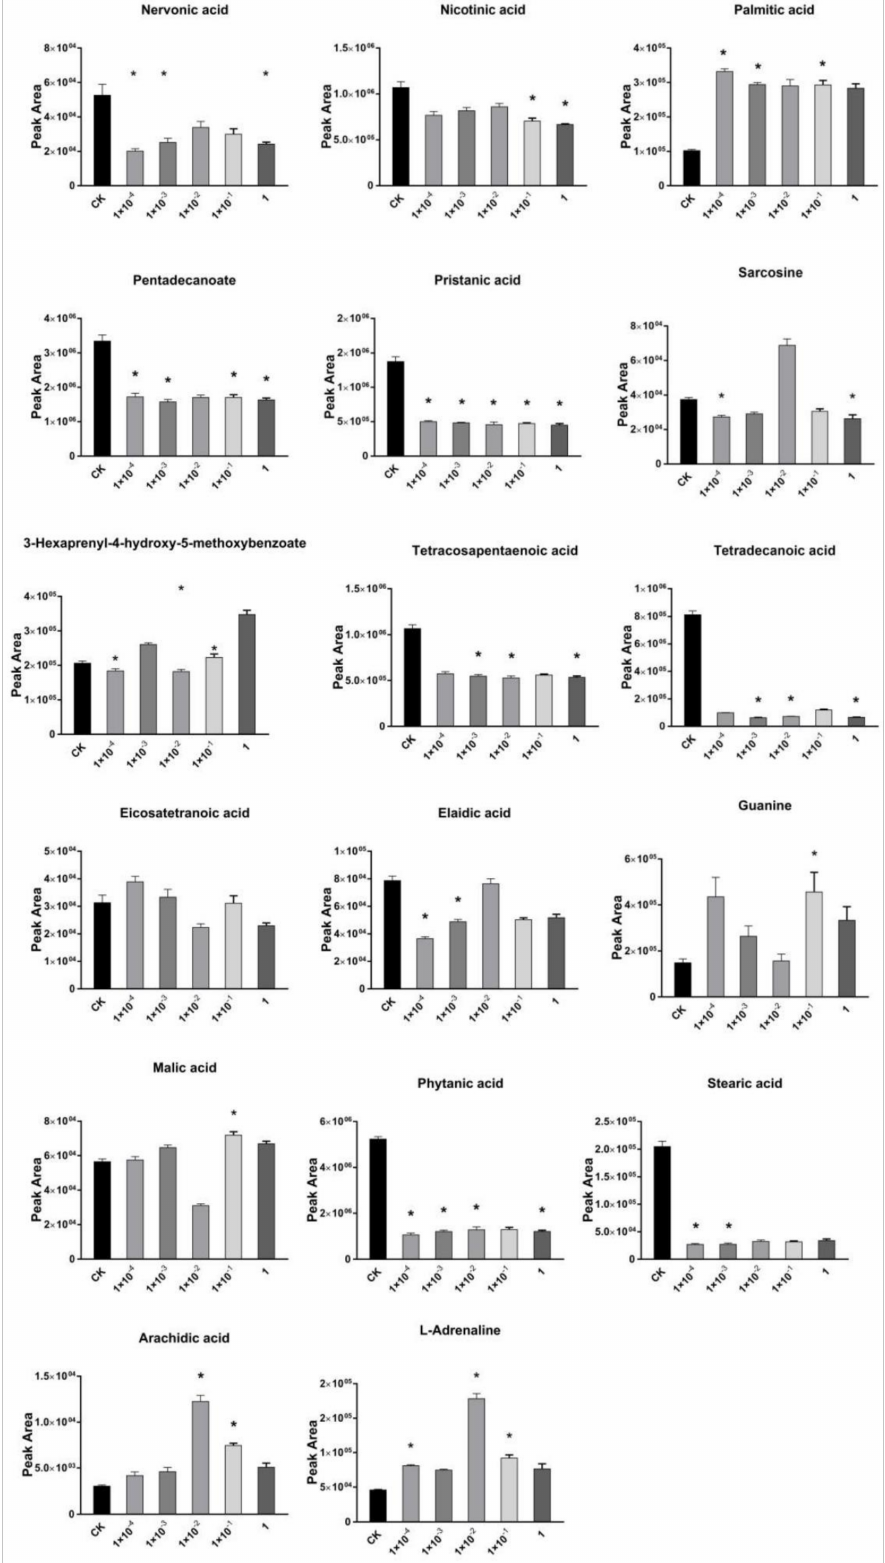
Figure 5. Changes in the concentration of metabolites of fatty acid in Tubifex exposed to Dufulin. Error bars indicate standard deviation (SD). (*: p <